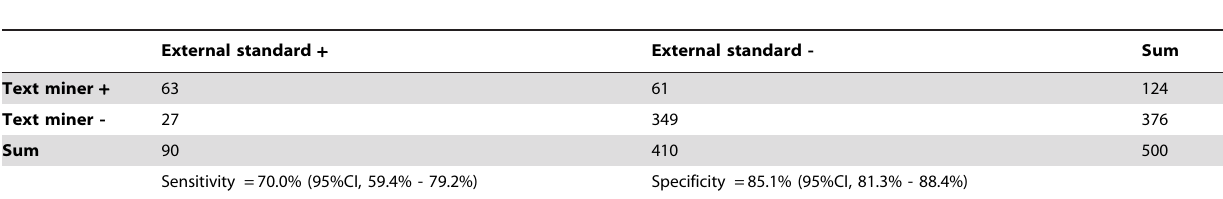
Table 1. From a random sample of 500 companion animal cases of diarrhea, the accuracy of the text miner for classifying the cases as positive or negative for ‘ had diagnostic testing ’ when compared to a manual review of the medical records serving as the external